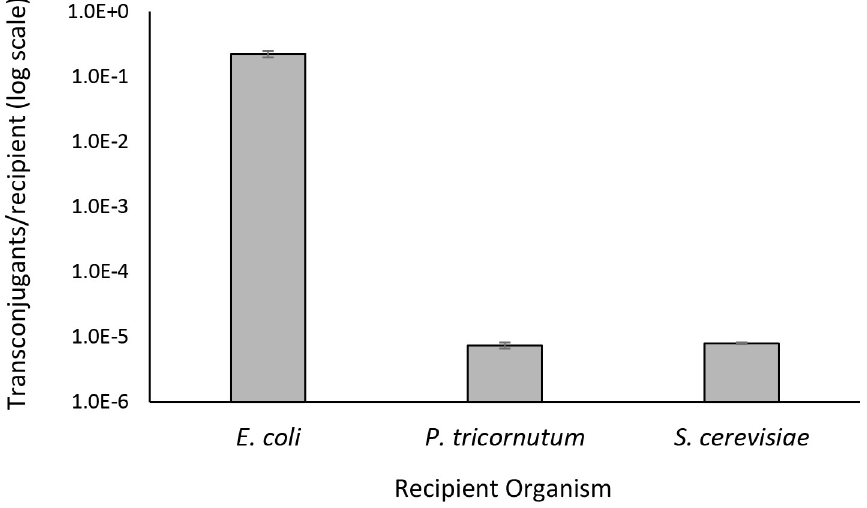
Fig 3. Conjugation efficiency of direct transfer of pAGE1.0 from S . meliloti donor to E . coli , S . cerevisiae , and P . tricornutum recipients. Conjugation efficiency for each donor-recipient pair. Post-conjugation non-selective plates and pAGE1.0 selective plates were used to determine the conjugation efficiency (calculated as transconjugants/ recipient) between each donor and recipient pair. Efficiencies are represented as bar plots with three biological and three technical replicates, with error bars illustrating standard error of the mean.